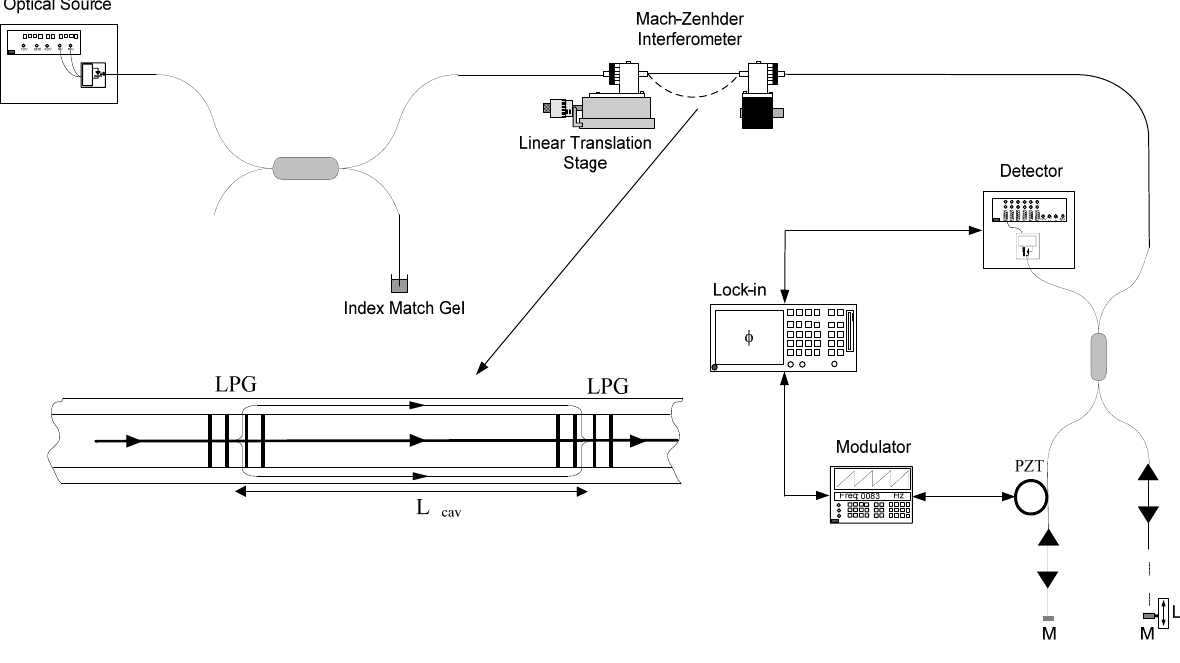
Figure 3. Interrogation system for LPG based Mach-Zehnder sensing structure. Adapted from